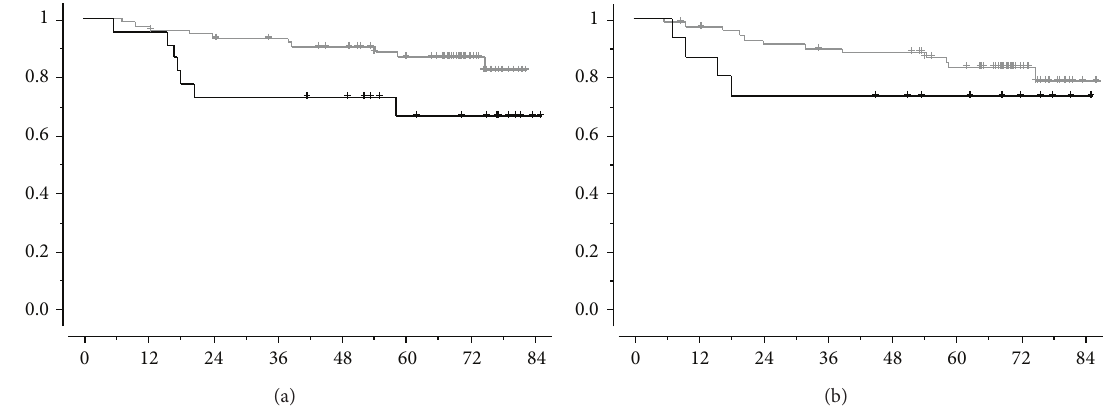
Figure 1: Distant metastasis-free survival, DMFS, in months, according to CTC detection before neoadjuvant chemotherapy ((a), 𝑃 = 0.04 ) or after neoadjuvant chemotherapy ((b), 𝑃 = 0.29 ). Black lines correspond to patients with ≥ 1 CTC/7.5mL and grey lines to patients with no CTC detected.